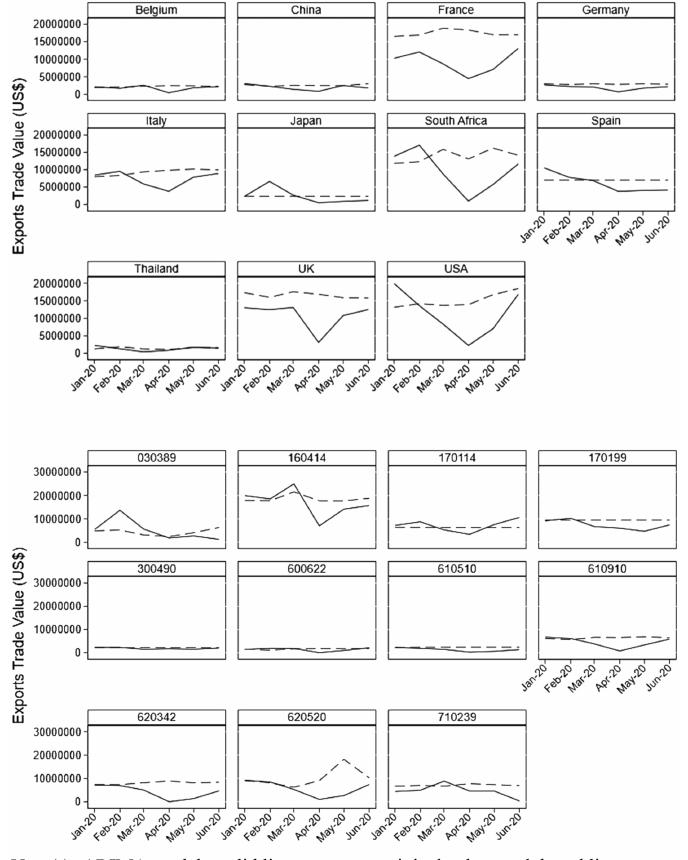
Figure 1. Predicted and